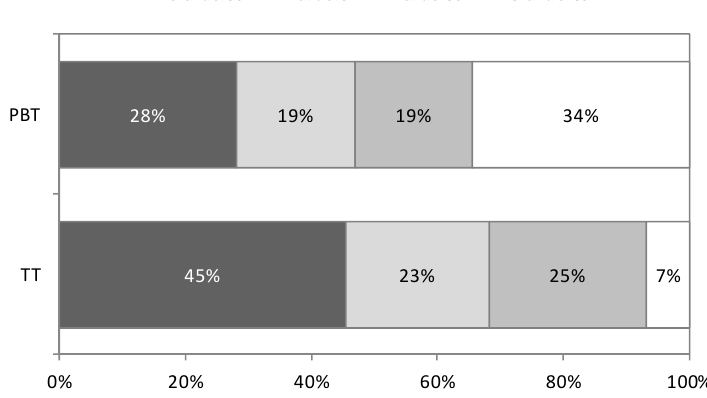
Figure 1. Number of theses-related articles according to the theses format (PBT = Publication-based theses, TT = Traditional theses).